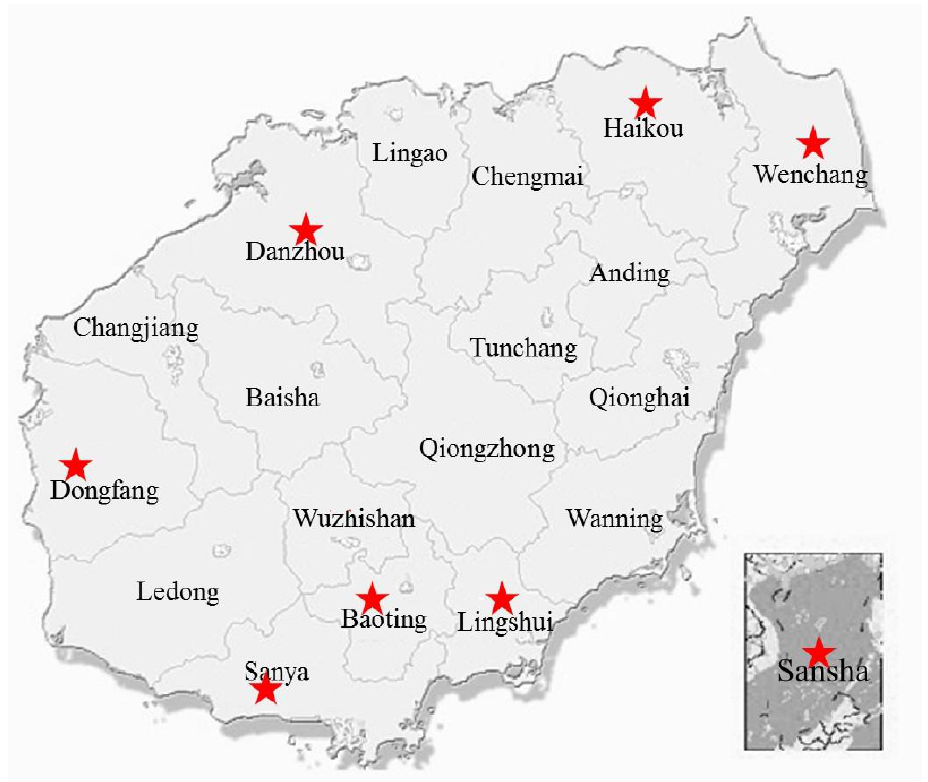
Figure 1. Geographic map of Hainan province in tropical China showing sites where environmental samples were collected for this study. The eight municipalities where samples were collected are marked by red stars.